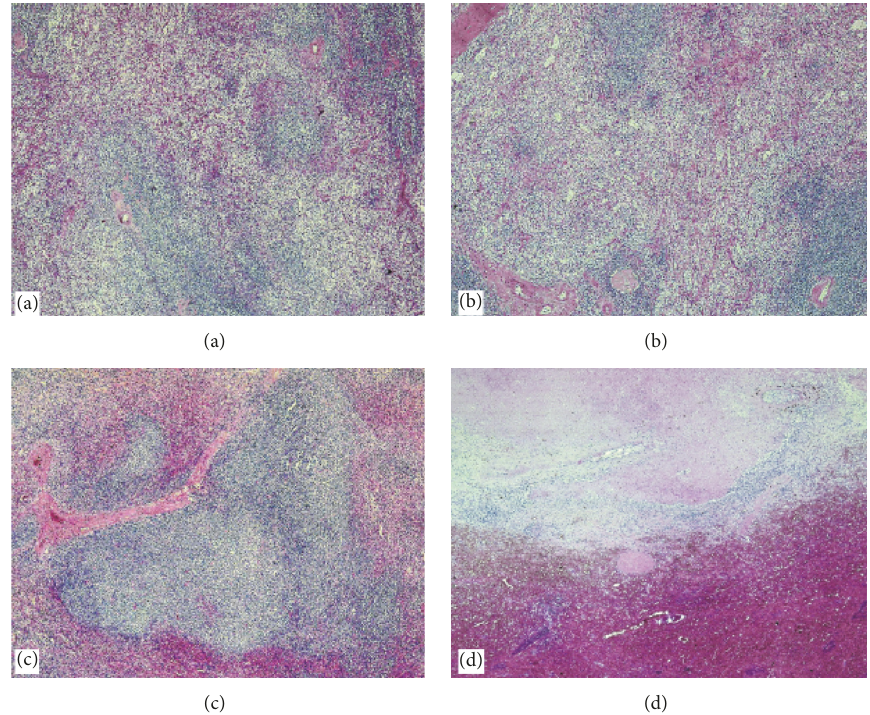
Figure3:Histopathologicalanalysisshowedadiffuseplurifocalnodularwhitepulphyperplasiacharacterizedbyanadmixtureoflymphocytes and aggregates of macrophages (H&E, 100x), follicular lymphoid hyperplasia (H&E, 100x) and pseudonodular necrotic area surrounded by prominent haemorrhagic parenchyma (H&E,